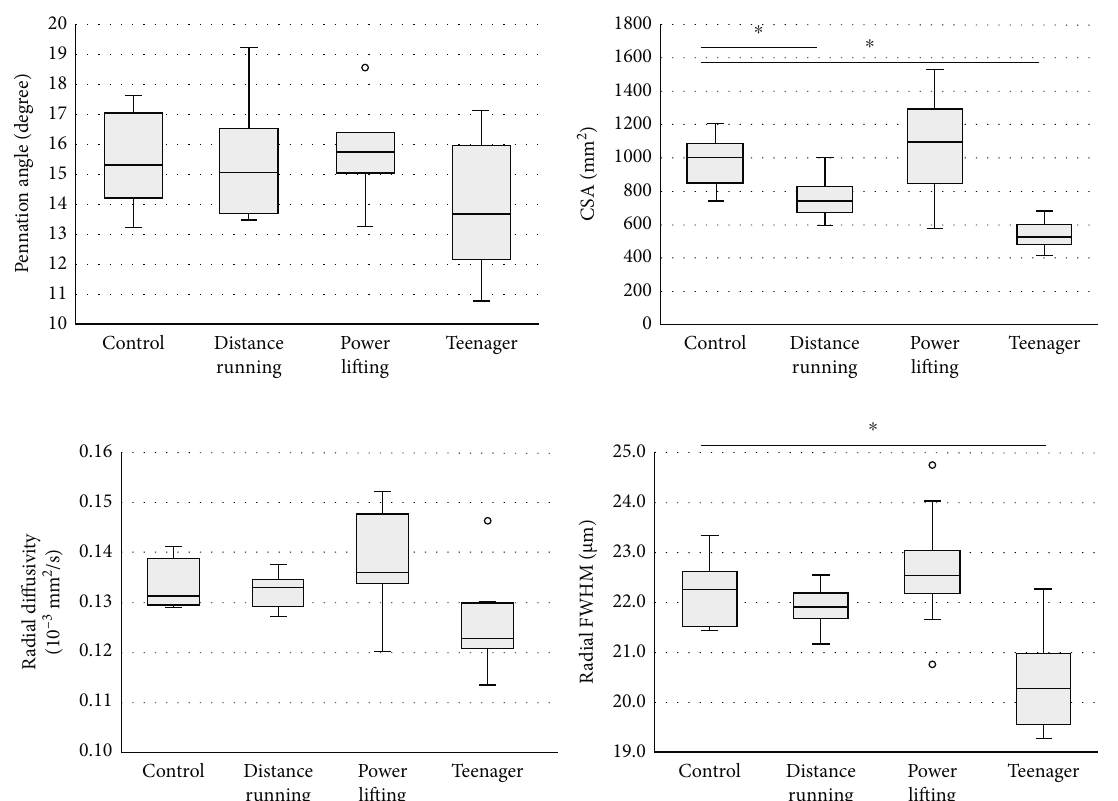
Figure 3: Quanti fi cation of magnetic resonance imaging parameters in the tibialis anterior muscle. Box and whisker plots: the bottom and top of the box are the fi rst and third quartiles. The band inside the box is the second quartile (median). The ends of the whiskers represent the minimum and maximum of all of the data. White circles are outliers. CSA: cross-sectional area; FWHM: full width at half maximum. ∗ P < 0 : 05 (Dunnett ’ s test;